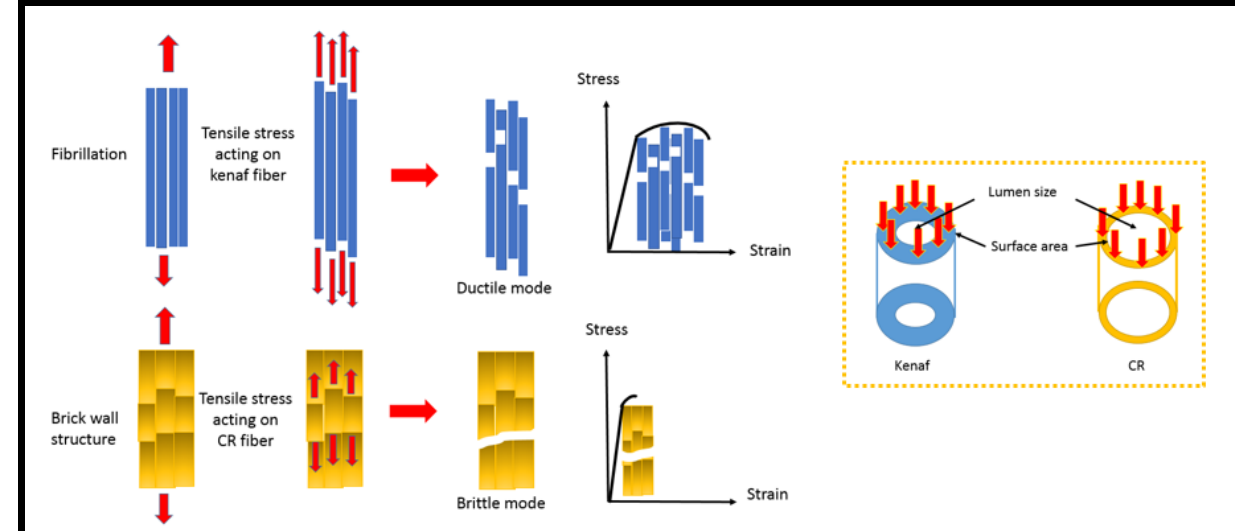
Figure 5. FE ‐ SEM images of tensile fractured specimens of ( a ) 10C:0K, ( b ) 7C:3K, ( c ) 5C:5K, ( d ) 3C:7K